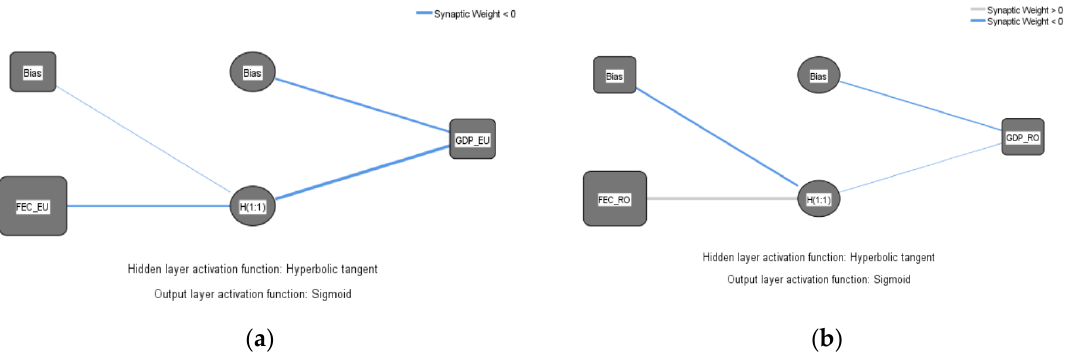
Figure 7. MLP network for identifying the influences of FEC on GDP at the EU and RO levels for 1995–2008: ( a ) EU; ( b ) RO.